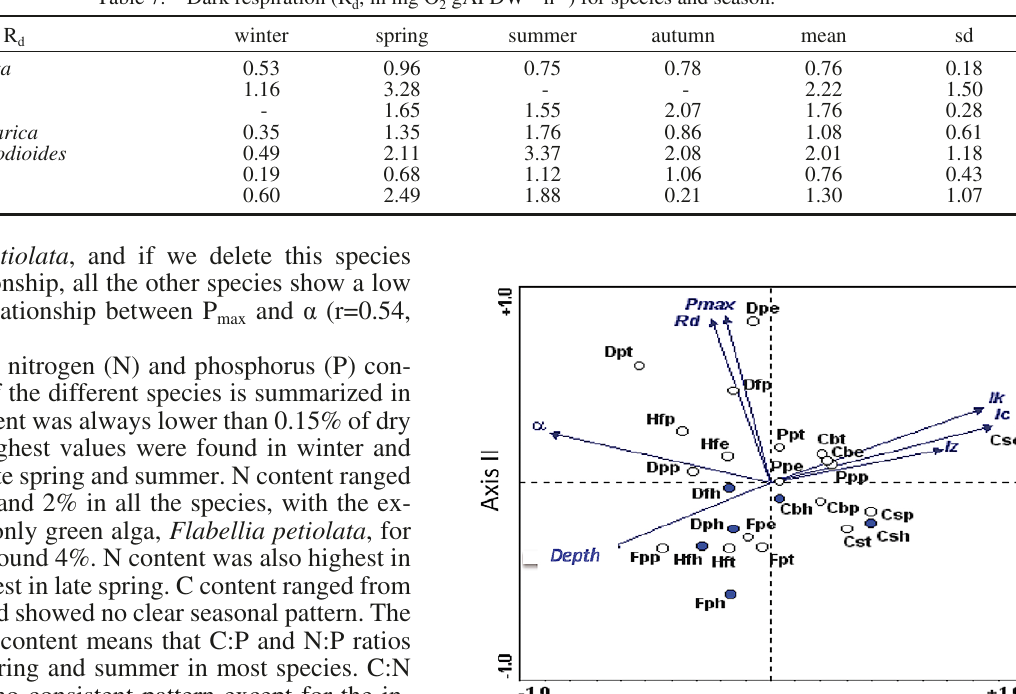
Table 7. – Dark respiration (R